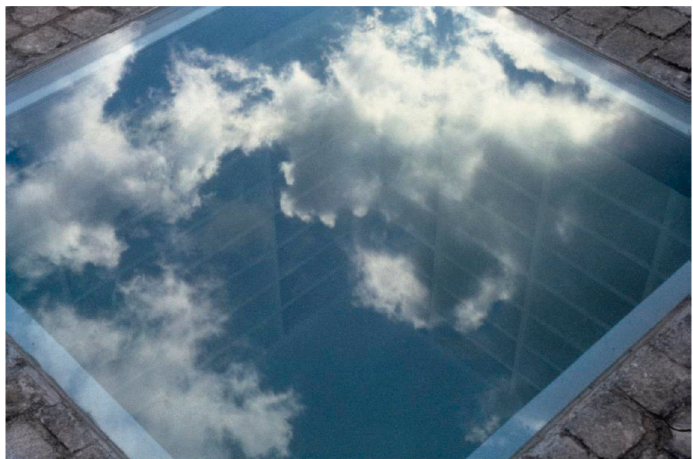
Figure 1. Micha Ullman, Library , 1995. Permanent (Bebelplatz, Berlin). Glass, concrete and plaster, excavation, light, 706 cm × 706 cm; depth: 530 cm, glass window: 120 cm × 120 cm. Photographers: Werner Zlein, Micha Ullman.